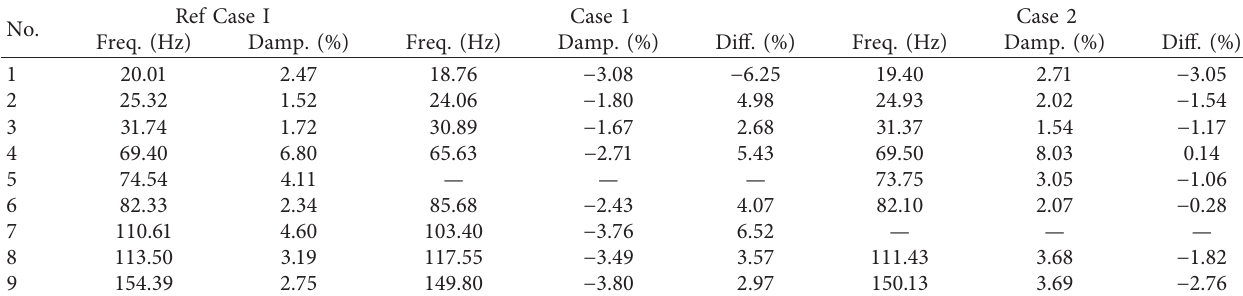
Figure 9: First 9 identified mode shapes in Ref CaseII: (a) 1 st mode; (b) 2 nd mode; (c) 3 rd mode; (d) 4 th mode; (e) 5 th mode; (f) 6 th mode; (g) 7 th mode; (h) 8 th mode; (i) 9 th mode. Table 1: Comparison of the identified modal information for Case 1 and Case 2.